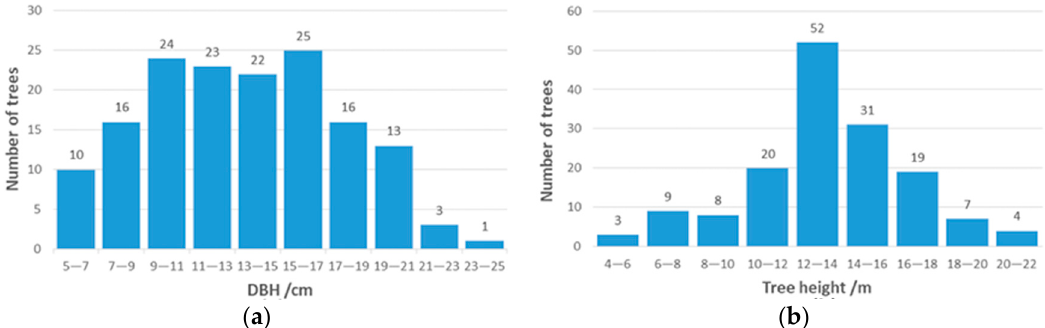
Figure 2. Histogram of diameter at breast height (DBH) and tree height distribution. ( a ) DBH; ( b ) tree height.